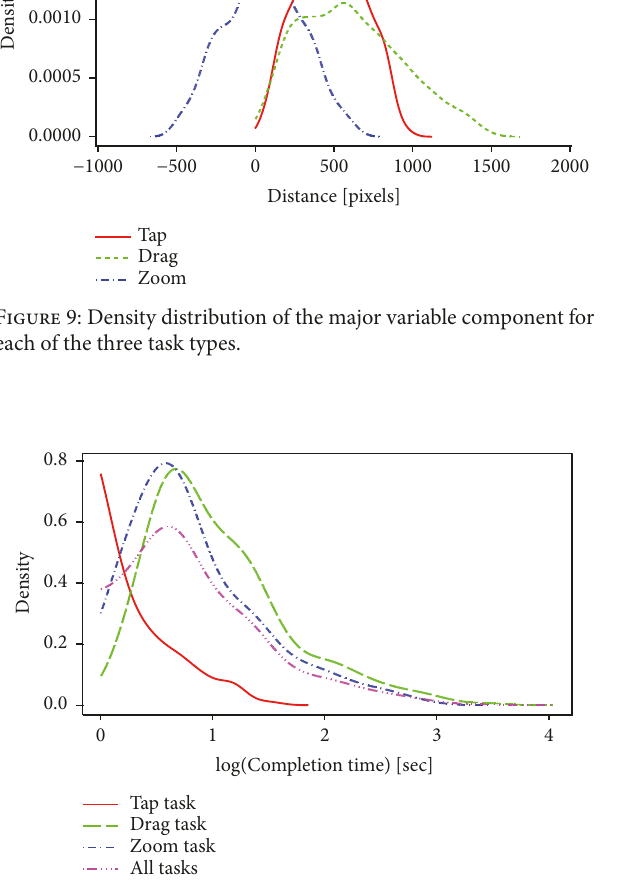
Figure 10: Density distribution of the log of completion time for the three task types.